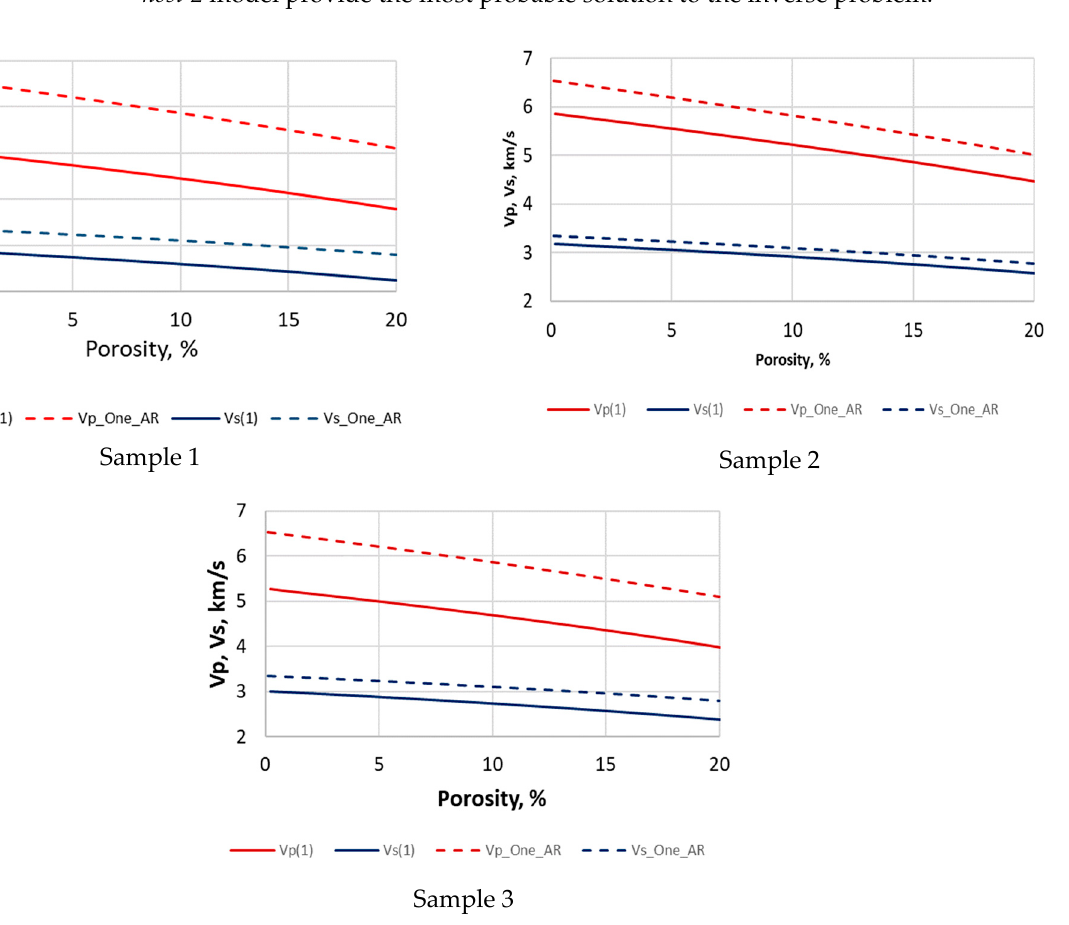
Figure 16. Prediction of P-wave velocities for fluid-saturated rocks. For fluid substitution, the Gassmann method was used. Microcrack parameters are constant and correspond to those found for each dataset. Notation (1), (2), (3) signifies the sets of data (Datasets 1–3) used to solve the inverse problem (see the description of the datasets in Section 3.2). Quasi-isometric porosity varies from 0.1 to 20%. The symbols on the curves correspond to porosity values for which the velocities were cal- culated.